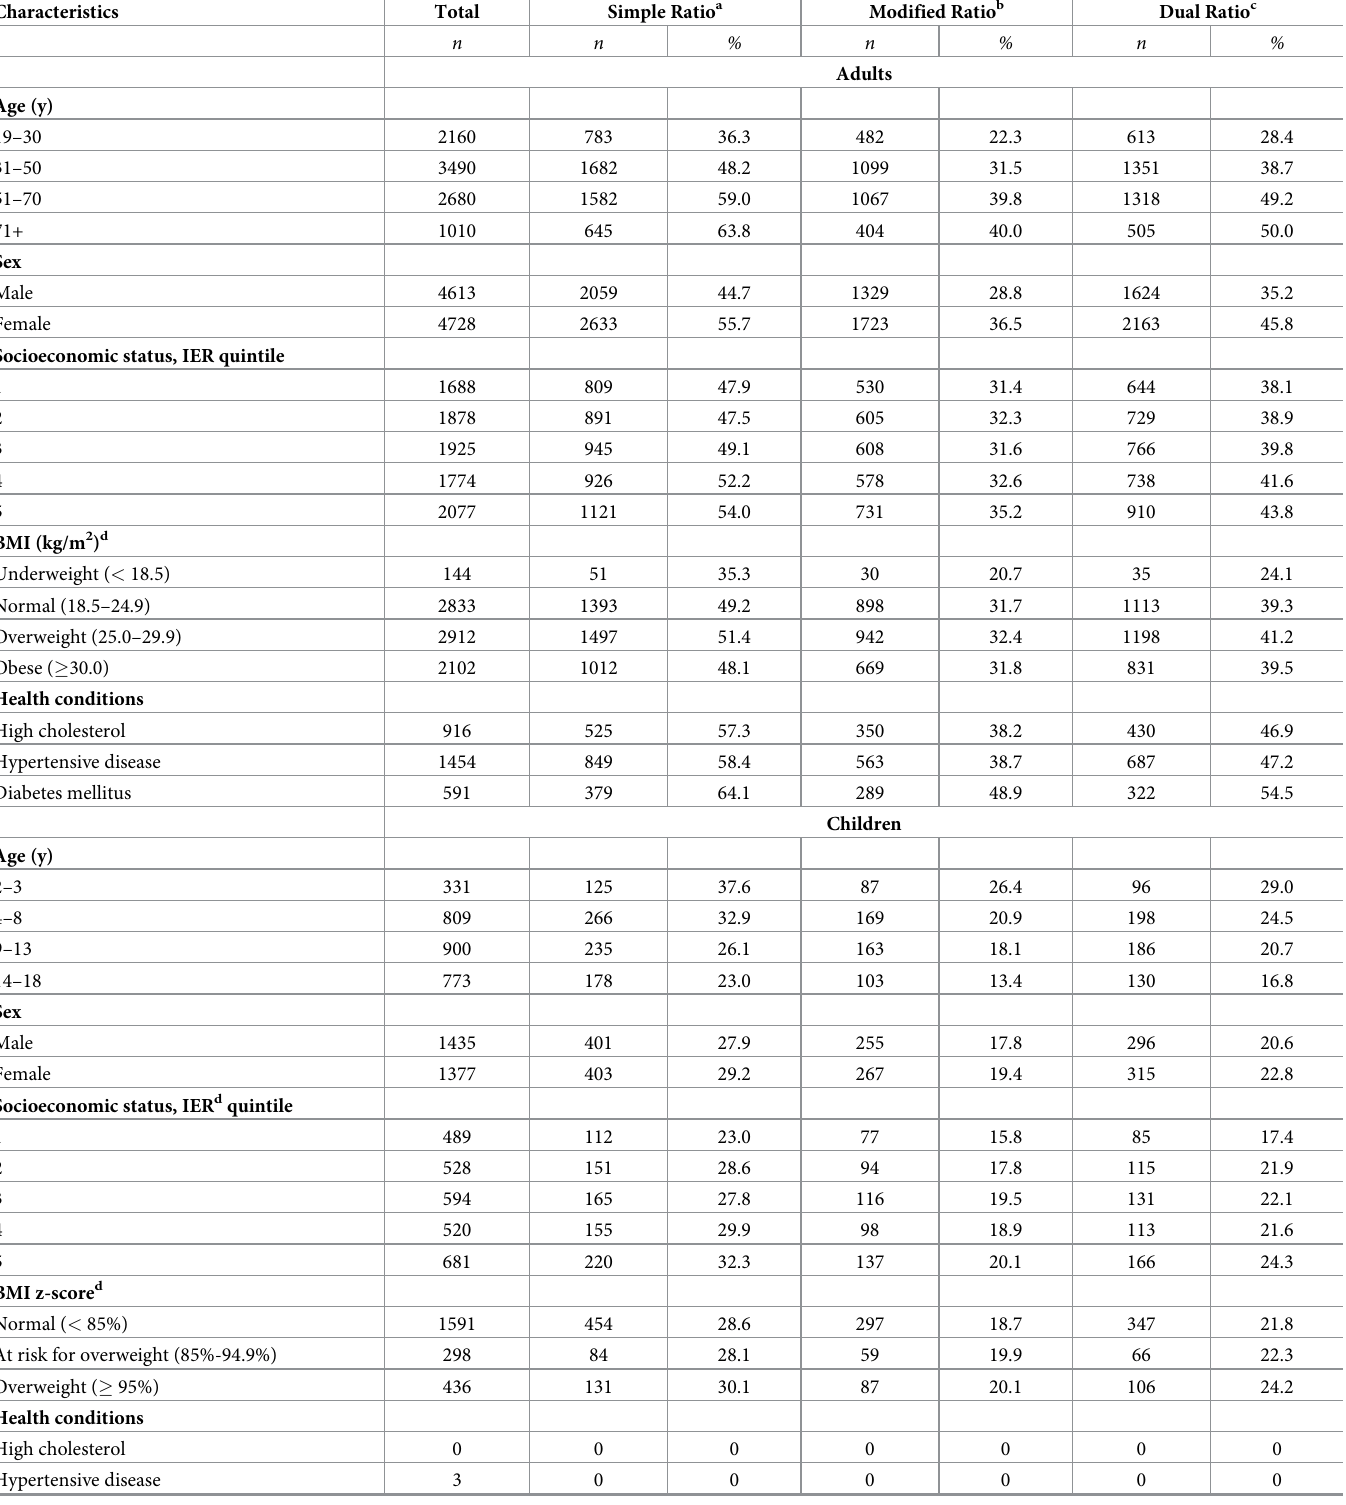
Table 1. Characteristics of participants in the 2011–12 Australian National Nutrition and Physical Activity Survey (NNPAS), by carbohydrate quality ratio. Characteristics Total Simple Ratio a